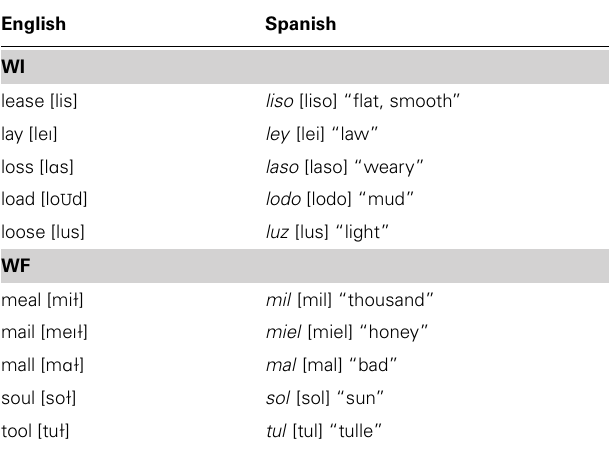
Table 1 | English and Spanish